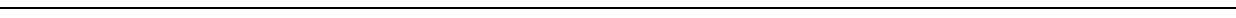
Fig. 5 Requirements for cell sorting from mixed aggregates. a Diagram of the assay: mixed aggregates composed of unlabelled cells and mGFP-expressing cells were fi xed and cryosectioned. GFP-expressing cells were detected with an anti-GFP antibody ( green ) and nuclei were counterstained with Hoechst ( red ). b – g Representative examples, with detailed views in right panels . b Aggregates of unlabelled and labelled IM cells, which distributed randomly. c Positive control: GFP-labelled IM cells sorted ef fi ciently from unlabelled ectoderm, forming sharply delimited groups. d – f Control IM cells were mixed with IM cells manipulated as follows: d C-cadherin overexpression; e expression of constitutively active RhoA; f EphrinB1+,3 expression; g substitution of mesodermal ephrinB2 and EphA4 (eB2MO and A4MO) with ectodermal ephrinB3 (eB3) and EphB4 (B4). Scale bars, main panel 200 µ m, enlargement 100 µ m. h Quanti fi cation of cell clustering, using a relative index of dispersion ( rID ). Clustering is de fi ned as departure from a random distribution (index of 1). Box plot as above. The number of aggregates is indicated on top. One-sided Mann – Whitney test was used for statistical comparison. Colour coded asterisks as follows: Red , comparison to control IM; dark and pale purple , comparison to ephrinB1 + 3 expression and to ephrin/Eph substitution (eB3 + B4 + eB2MO+ A4MO). Except for myosin depletion (MHCMO) and cadherin replacement (CcadMO + Ecad/Ncad), all manipulations led to some signi fi cant degree of clustering compared to control non-manipulated IM. Ephrins/Eph substitution led to the highest degree of clustering. i Quanti fi cation of the relative length of heterotypic interface ( rLHI ), de fi ned as the ratio between the total length of heterotypic contacts and the theoretical minimal interface, calculated as the perimeter of a circle encompassing the total area of the labelled population (Supplementary Fig. 6). Conditions of ephrin ectopic expression alone or in combination with EphA4 depletion led to a signi fi cant shortening of rLHI. Separation was further improved by substitution of mesodermal with ectodermal ephrin/Eph. None of the other conditions signi fi cantly departed from the negative control aggregates of non-manipulated IM. Plot, statistical test and colour code as in